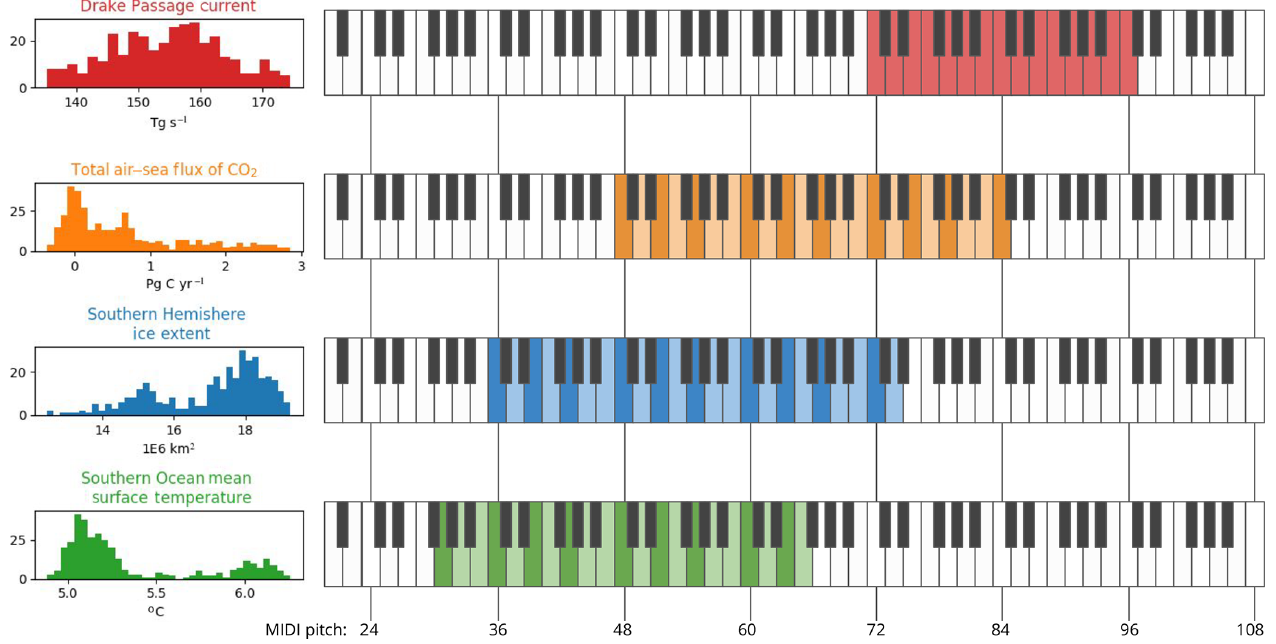
Figure 2. The musical range of each of the data sets used in the “Earth System Allegro”. The four histograms on the left-hand side show the distributions of the data used in the piece, and the right-hand side shows a standard piano keyboard with the musical range available in each data set. In this piece, the Drake Passage current, shown in red, is free to vary within a two octave range of the C major scale. The other three data sets have their own ranges but are limited to the notes in the chord progression, namely C major, G major, A minor and F major. The dark coloured keys are the notes in C major chord, but the lighter coloured keys show the other notes which are available for the other chords in the progression. Note that both the C major scale and chord do not include any of the ebony keys on a piano, but these notes could be used if they were within the available range and appeared in the chord progression used.